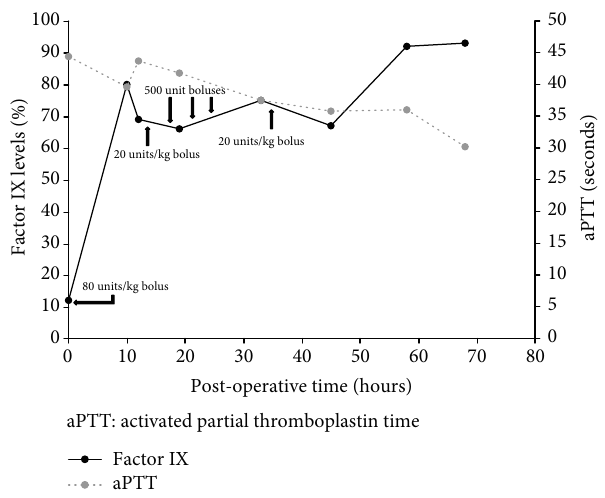
Figure 1: Detailed course of factor IX and serum aPTT